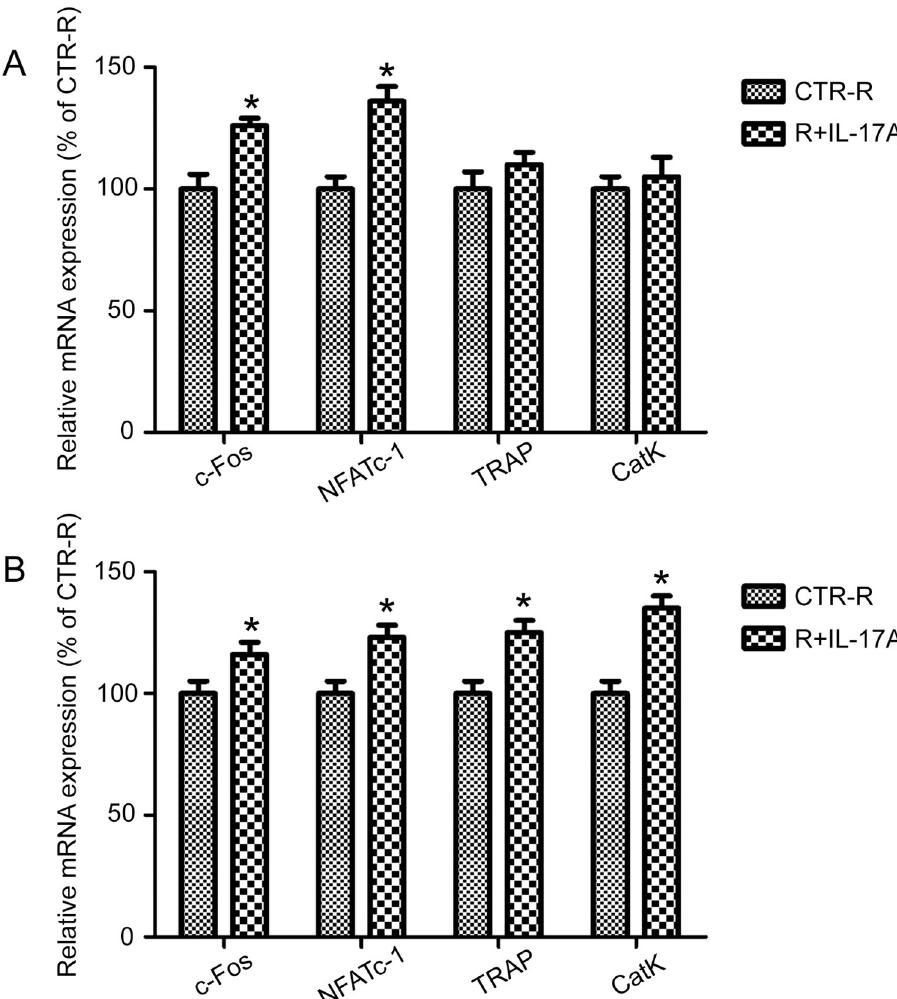
Fig 2. IL-17A promotes the expression of osteoclast-related genes involved in osteoclastogenesis. The mRNA expression levels of c-Fos , NFATc1 , TRAP , and CatK were detected in the presence of RANKL (50 ng/ml) after IL-17A (1 ng/ml) treatment for (A) 1 and (B) 3 d. Data represent fold-changes in target gene expression normalized to that of GAPDH and are expressed as a percentage of the level in cells not treated with IL-17A (CTR-R), which was set to 100%. Values represent the mean ± SD (n = 4). � p <